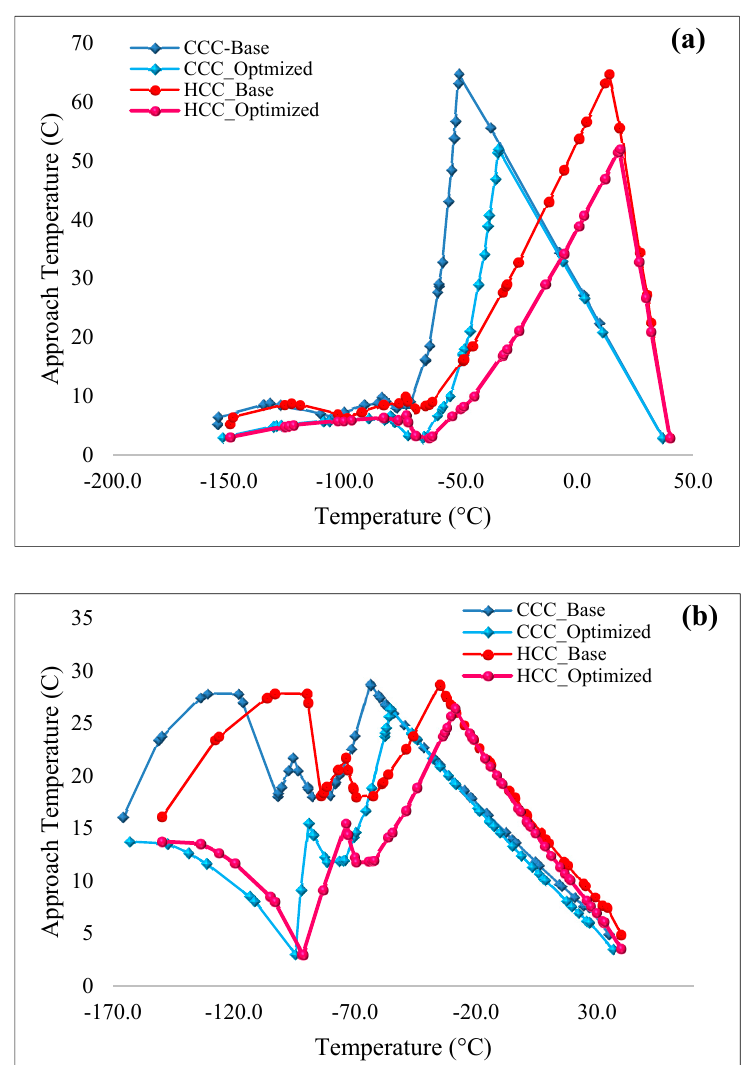
Figure 6. Temperature di ff erence composite curves (TDCCs) of base and optimized cases for CHX-01 Figure 6. T emperature difference composite curves (TDCCs) of base and optimized cases for CHX-01 of ( a ) SMR and ( b ) N 2 dual expander LNG of ( a ) SMR and ( b ) N 2 dual expander LNG processes.